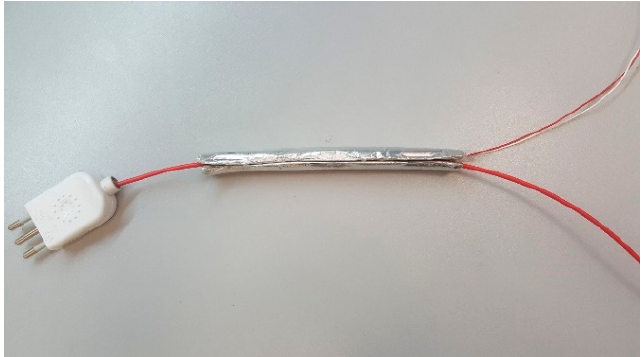
Figure 7. Prototype of the capacitive probe.